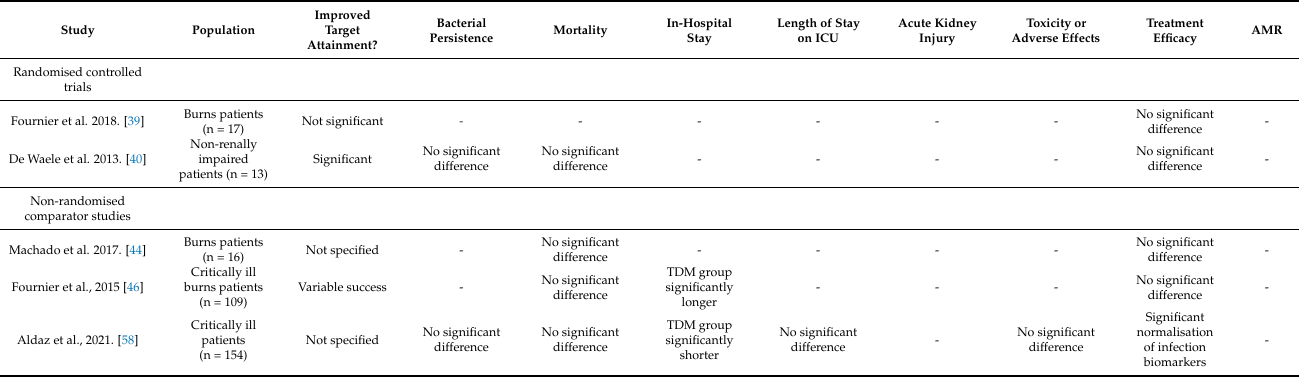
Table 4. Effect of carbapenem TDM in health